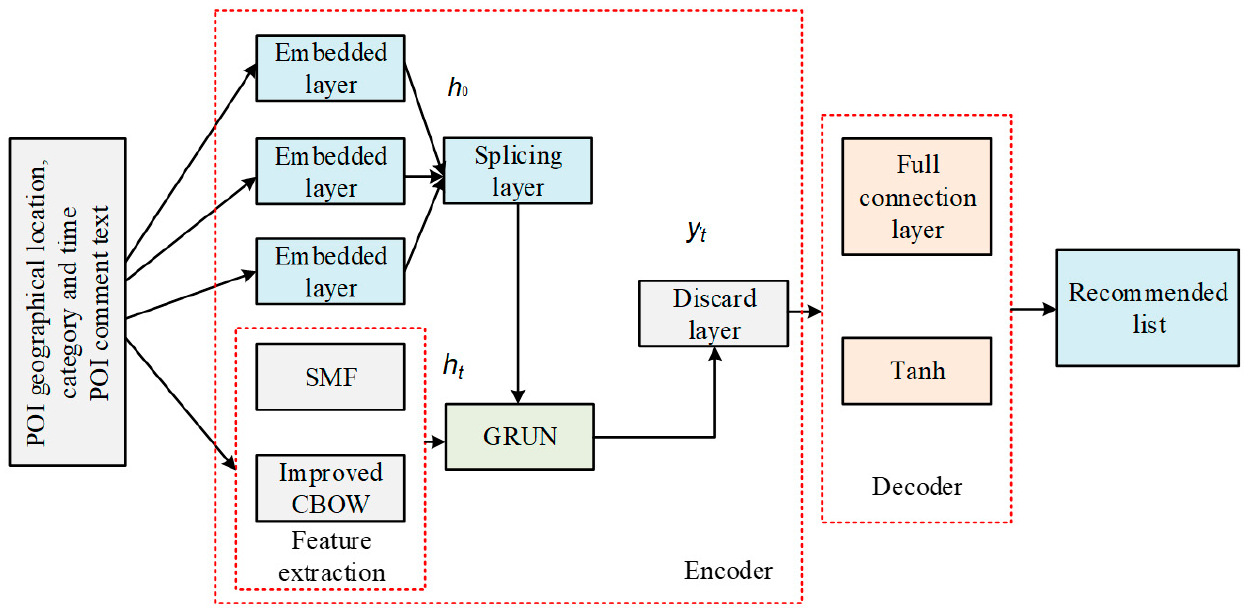
Figure 1. Overall framework of the proposed model.